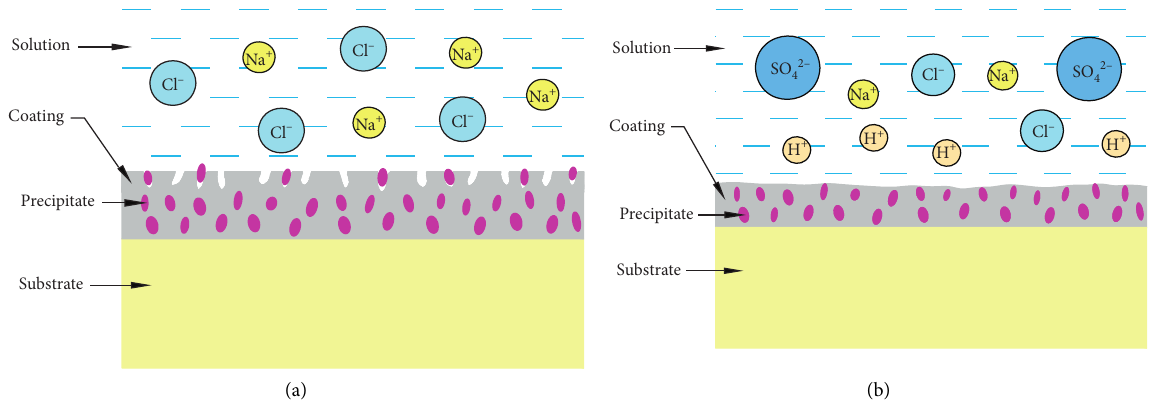
Figure 11: Schematic diagrams of the corrosion mechanisms for laser cladding process prepared Ni45 coatings in (a) 0.5M NaCl and (b) 0.5M NaCl+0.5 M H 2 SO 4 solutions.